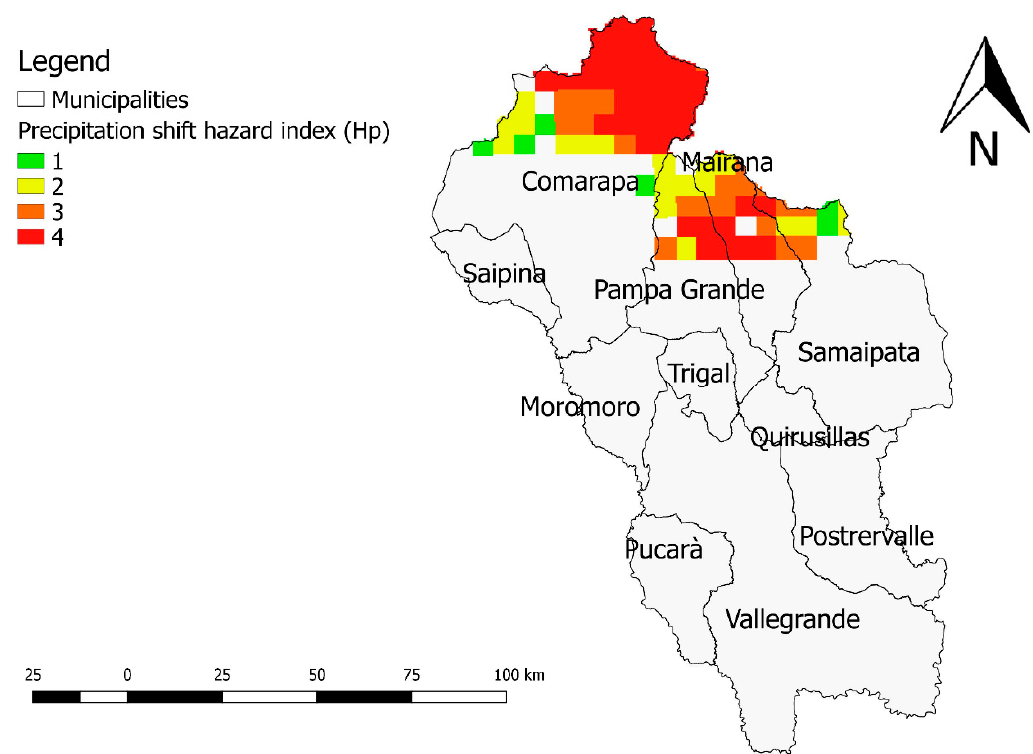
Figure 6. Precipitation shift hazard map (Hp) of the “Valles Cruceños” region, Hp varies from 1 (lower) to 4 (higher). Bolivia, 2019.